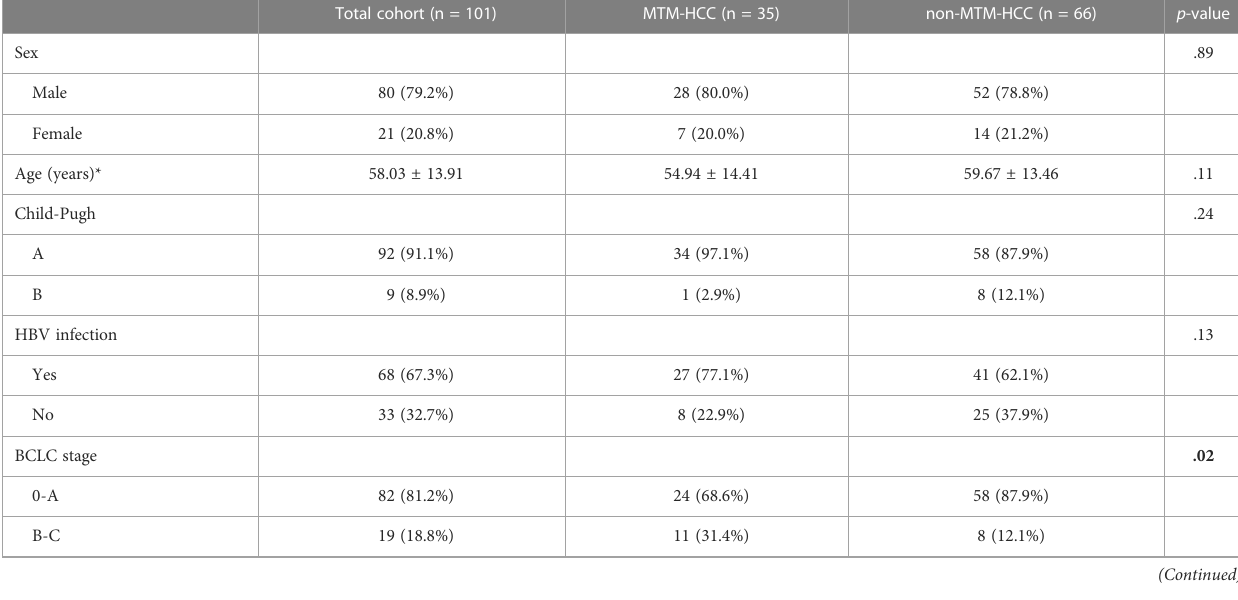
TABLE 1 Baseline demographic, clinical, and pathologic characteristics of MTM-HCCs and